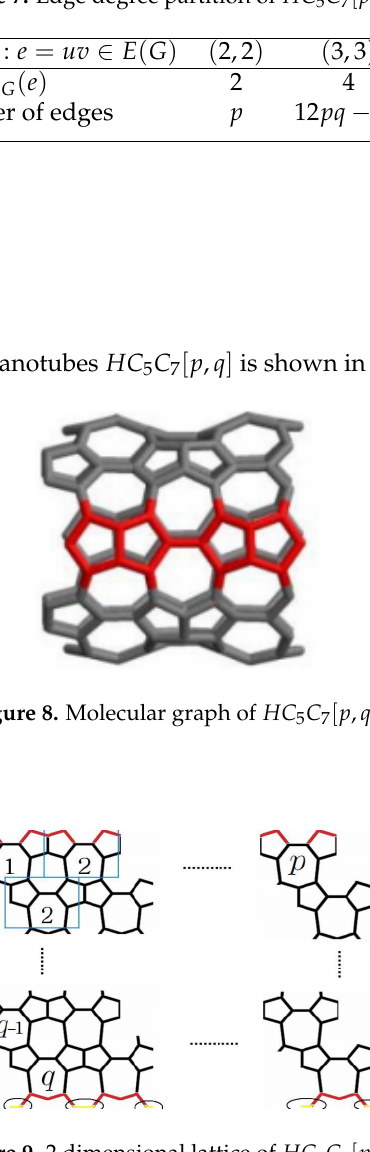
Figure 9. 2 dimensional lattice of HC 5 C 7 [ p , q ]